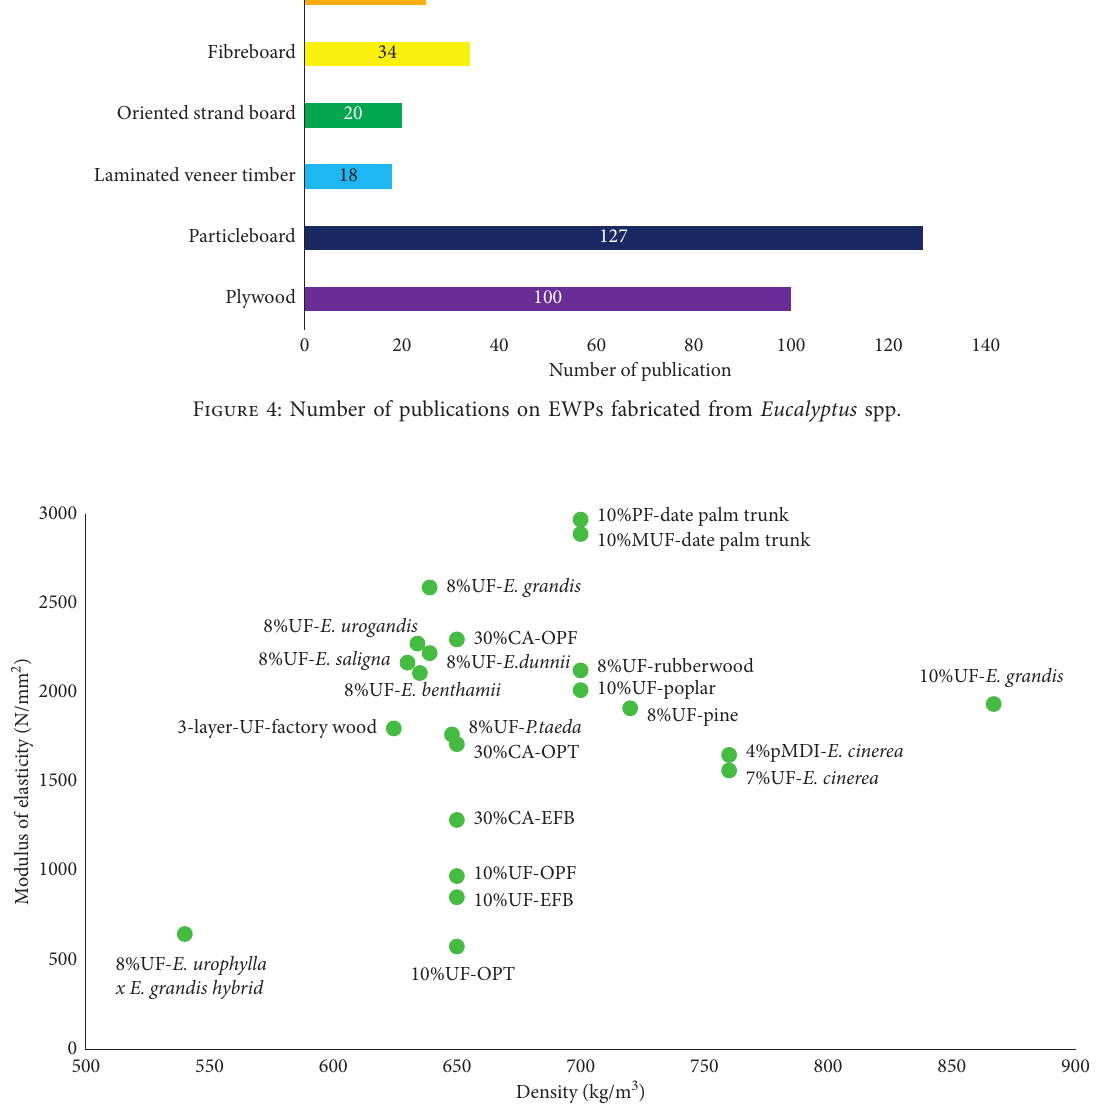
Figure 5: MOE-density chart for particleboard made with Eucalyptus spp. and other wood species [35, 38–46]. ∗ Note: UF: urea- formaldehyde; PF: phenol-formaldehyde; MUF: melamine-urea-formaldehyde; pMDI: polymeric 4,4-diphenylmethane diisocyanate; CA: citric acid; OPT: oil palm trunk; OPF: oil palm frond; EFB: empty fruit bunch.